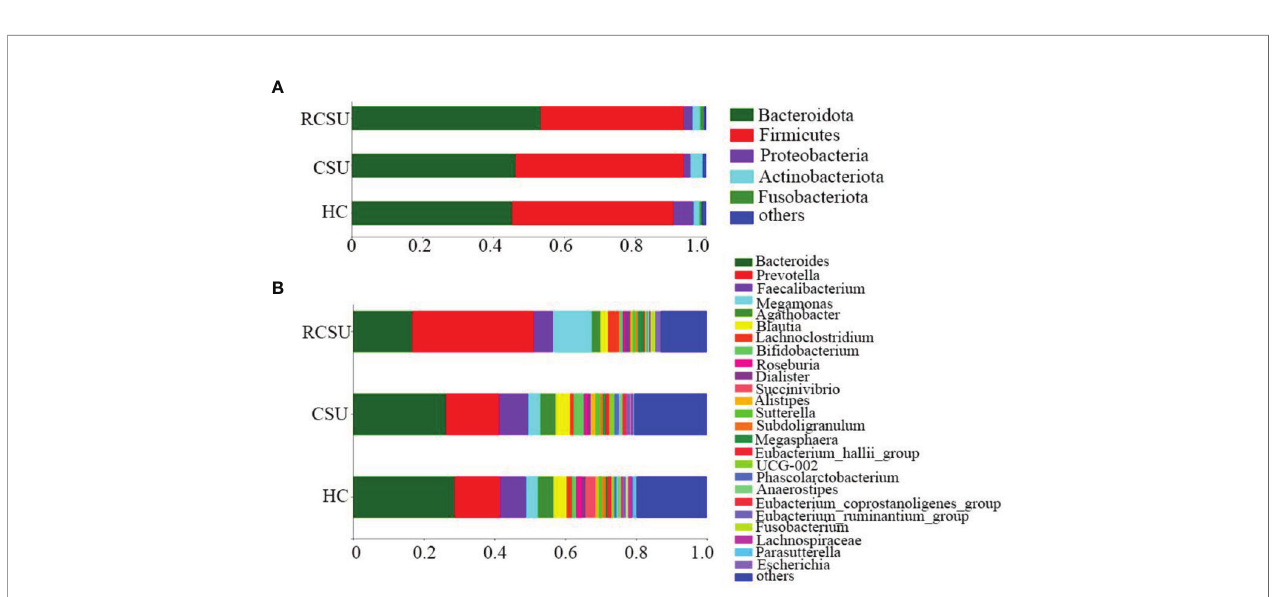
FIGURE 3 | The composition and relative proportion of gut bacteria in the three groups on Phylum level (A) and Genus level (B)